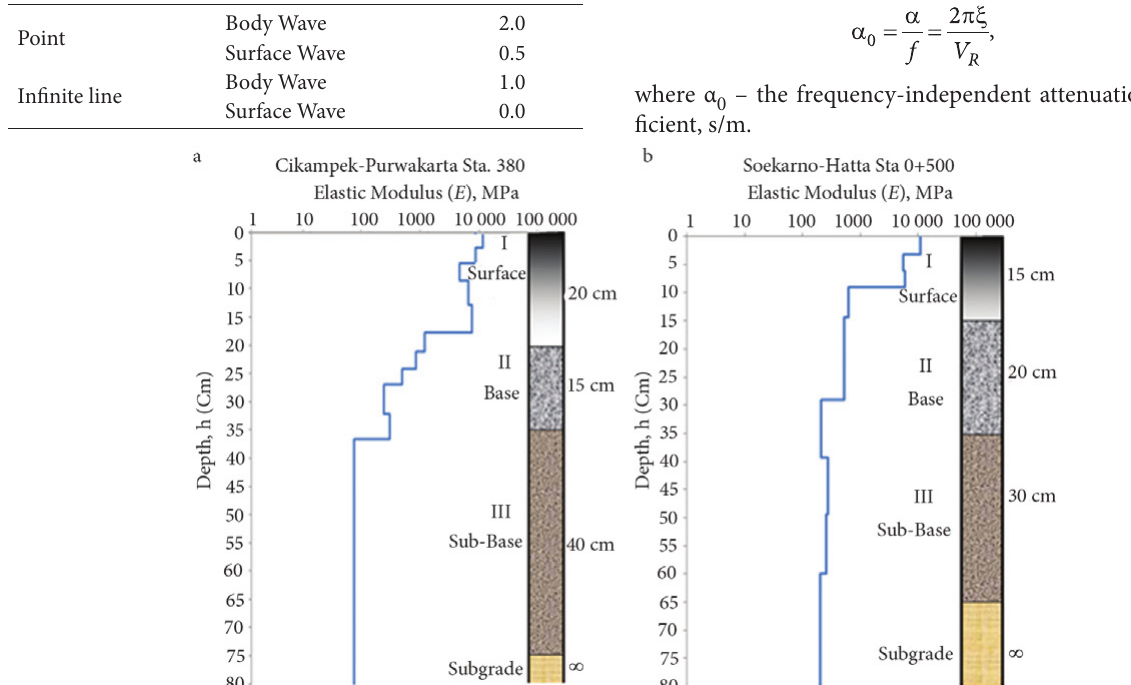
table 1. Attenuation radiation damping factor ( n ) with the source on the surface (Kim, Lee 1998) Source type